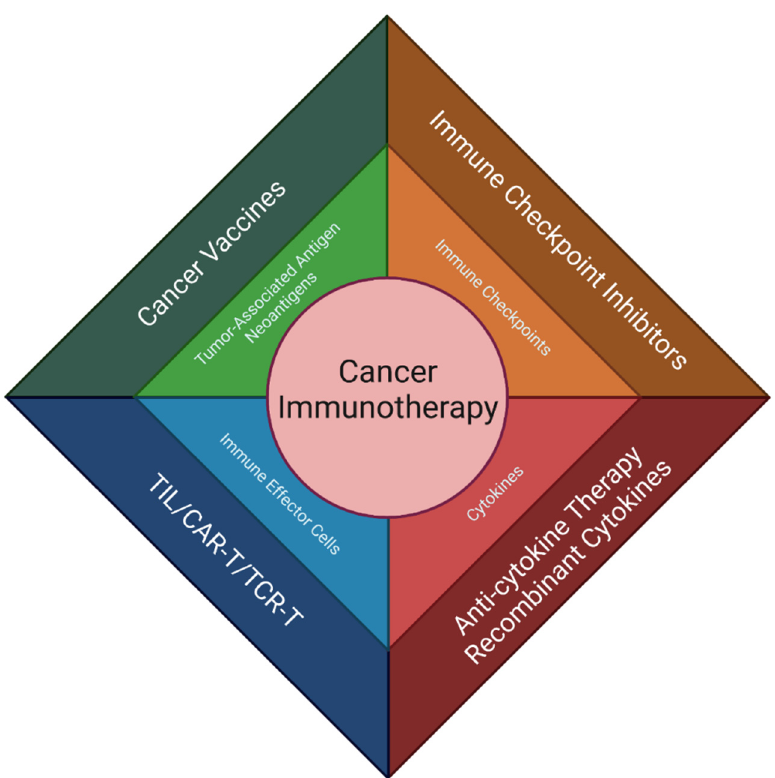
Figure 1. An overview of various forms of anti-cancer immunotherapy. The outer boxes outline different immunotherapeutic interventions. The inner boxes list corresponding immune targets.